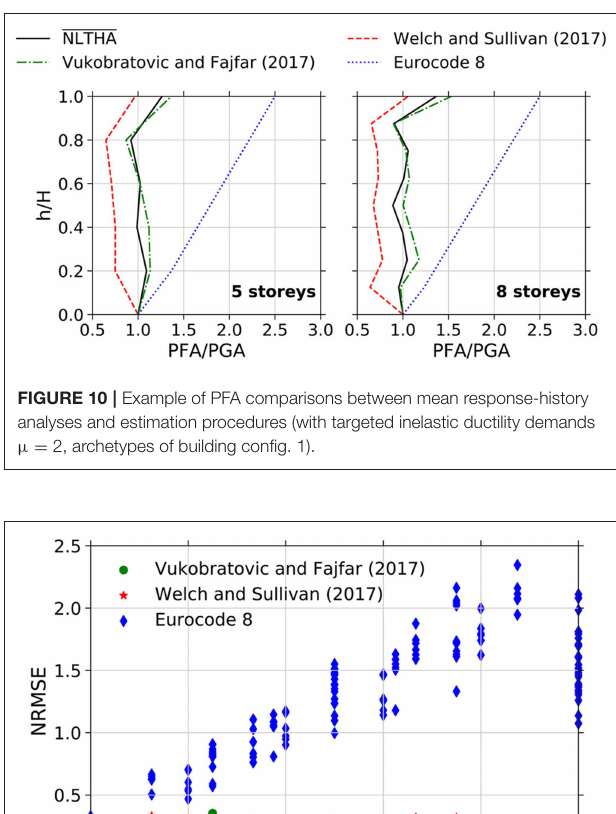
comparison of mean NLTHA results for different ductility demands, with the roof level generally displaying the largest reductions of PFA/PGA across all floor levels (see Figure 9